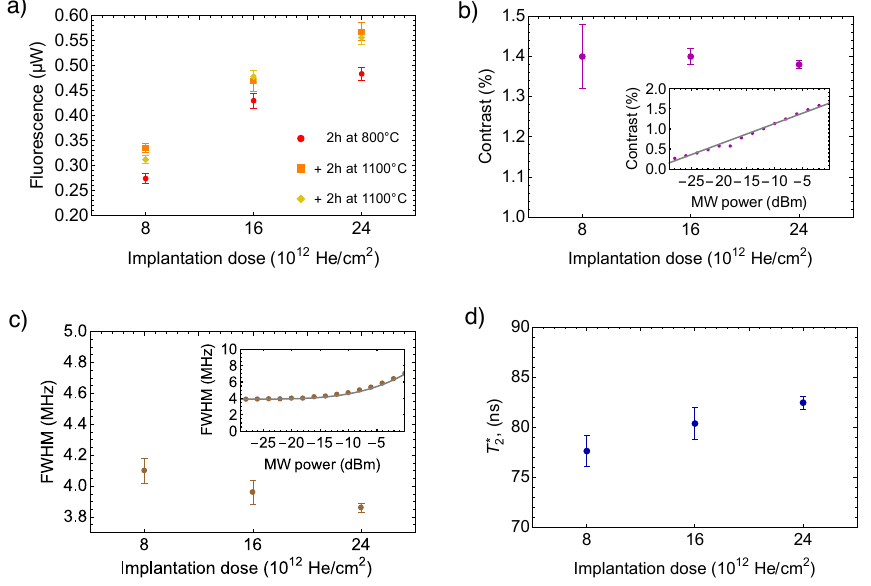
Figure 3. ODMR measurements: ( a ) Off-resonance fluorescence intensity for three subsequent an- nealing steps versus cumulative implantation dose. ( b ) Contrasts of the ODMR signals at | 0 (cid:105) ↔ | − 1 (cid:105) spin transition versus the cumulative implantation dose. The contrasts are shown for − 5 dBm of MW power (see the inset). ( c ) The FWHM of the ODMR signals at | 0 (cid:105) ↔ | − 1 (cid:105) spin transition versus the cumulative implantation dose. The FWHMs linewidths are shown for − 25 dBm of MW power (see the inset). ( d ) Calculated from the FWHM inhomogeneously broadened transverse relaxation T ∗ 2 versus the cumulative implantation dose. A complete breakdown of implantation doses can be found in Table 1. The error bars represent the standard error (SE) of the data. All ODMR data except the fluorescence intensity show no significant correlation with the annealing temperature or duration; therefore, the contrasts, FWHMs, and T ∗ after averaging over all three annealing steps are shown 2 for